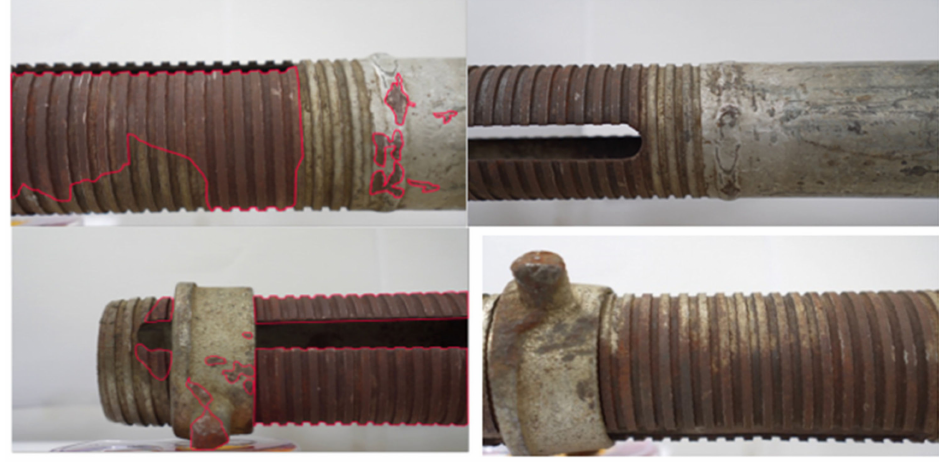
Figure 4. Real images with GT masks.